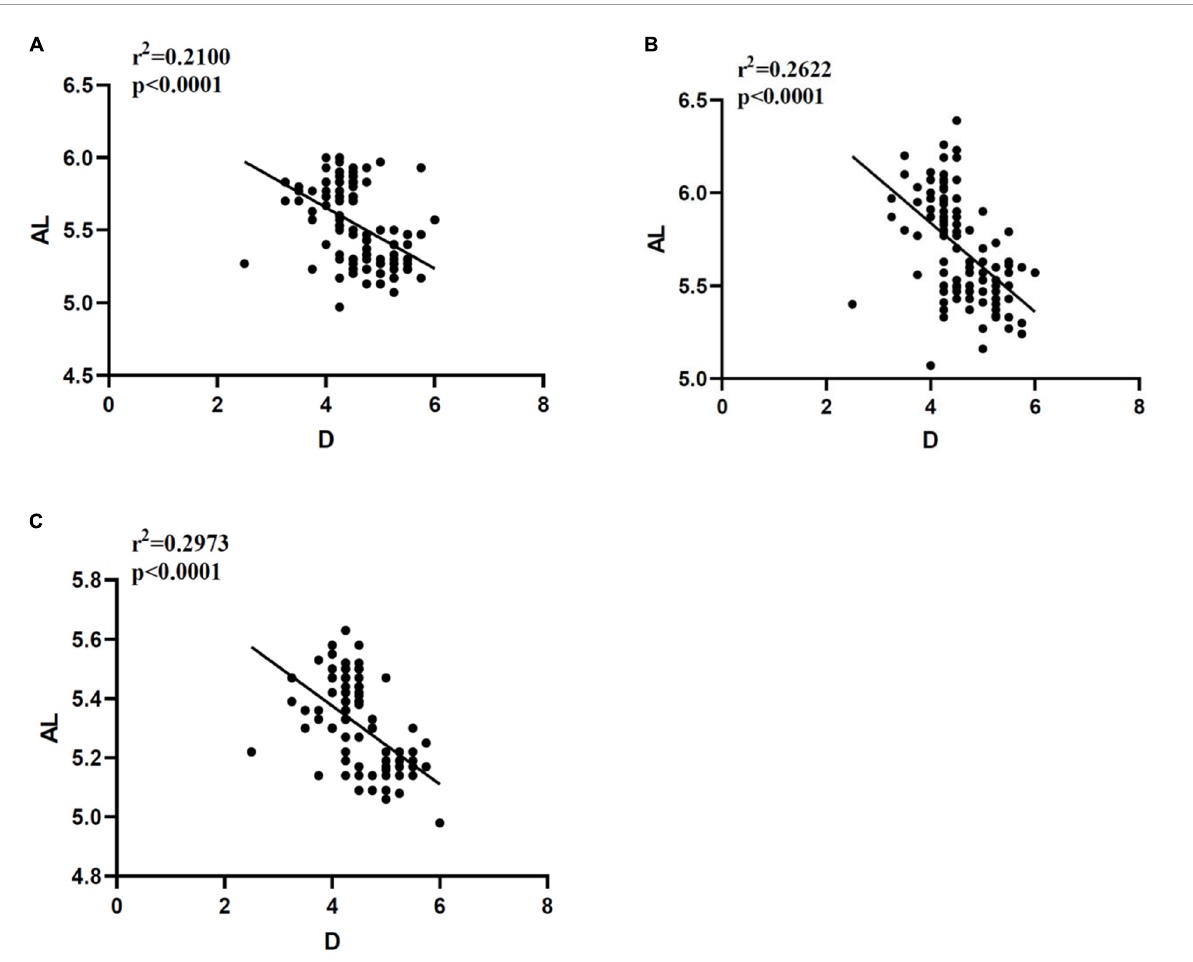
FIGURE5 Correlation analysis between AL and D measured in different ways. (A) Correlation between AL and D measured by Quantel A-B scan. (B) Correlation between AL and D measured by Vernier caliper. (C) Correlation between AL and D measured by OD-1 A scan. AL, axial length; D, diopter; r2, Pearson correlation coefficient; p < 0.0001 indicates that there is great statistical